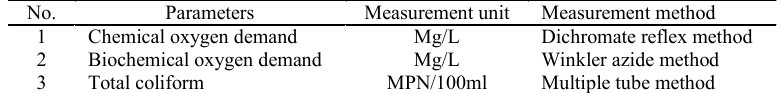
Table 2: Methods used to monitor water quality